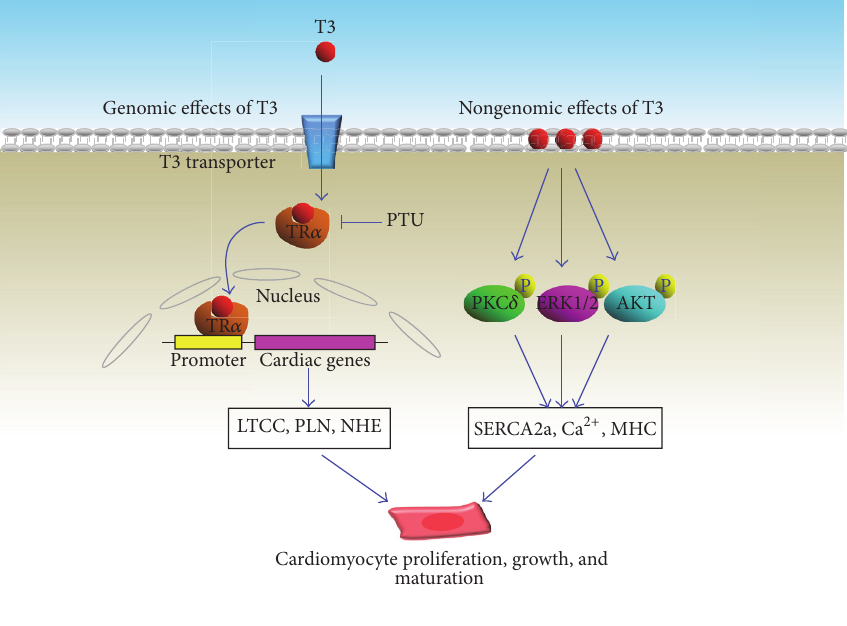
Figure 1: T3 promotes the proliferation, growth, and maturation of cardiomyocytes. LTCC: L-type calcium channel; PLN: phospholamban; NHE: Na + /H + exchanger; MHC: myosin heavy